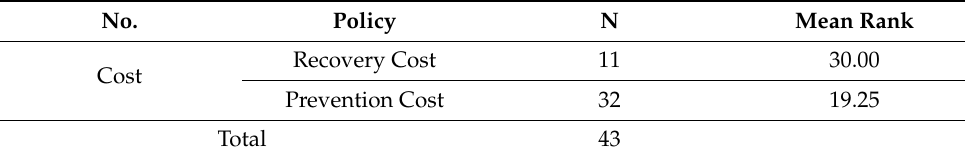
Table 5. Total anticipation policy (US$) costs for 32 non-crisis countries. No.